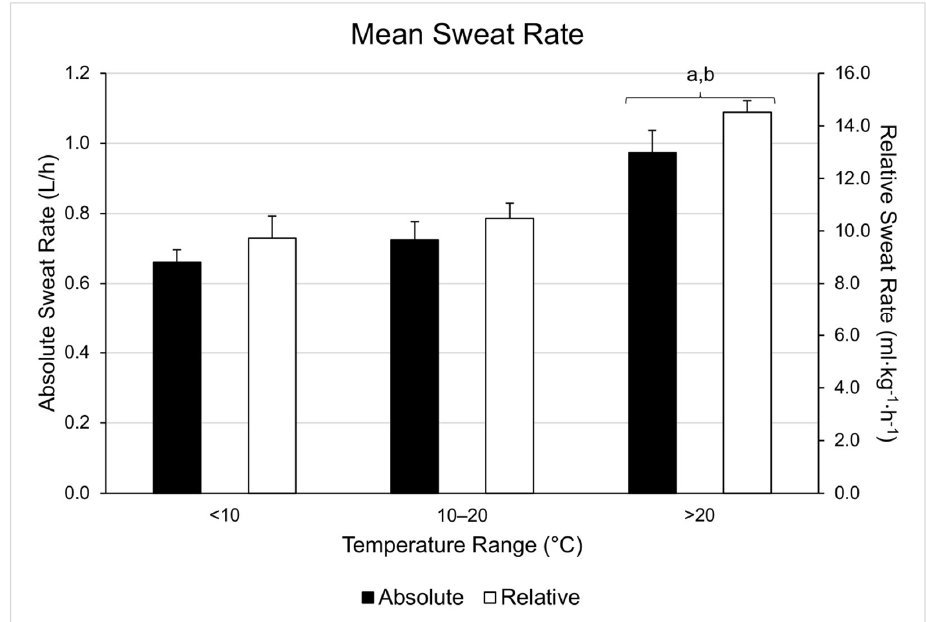
Figure 1. Mean sweat rates (absolute: L/h; relative: mL∙kg −1 ∙h −1 ) within each temperature range. a = significantly different from LOW, b = significantly different than MOD.